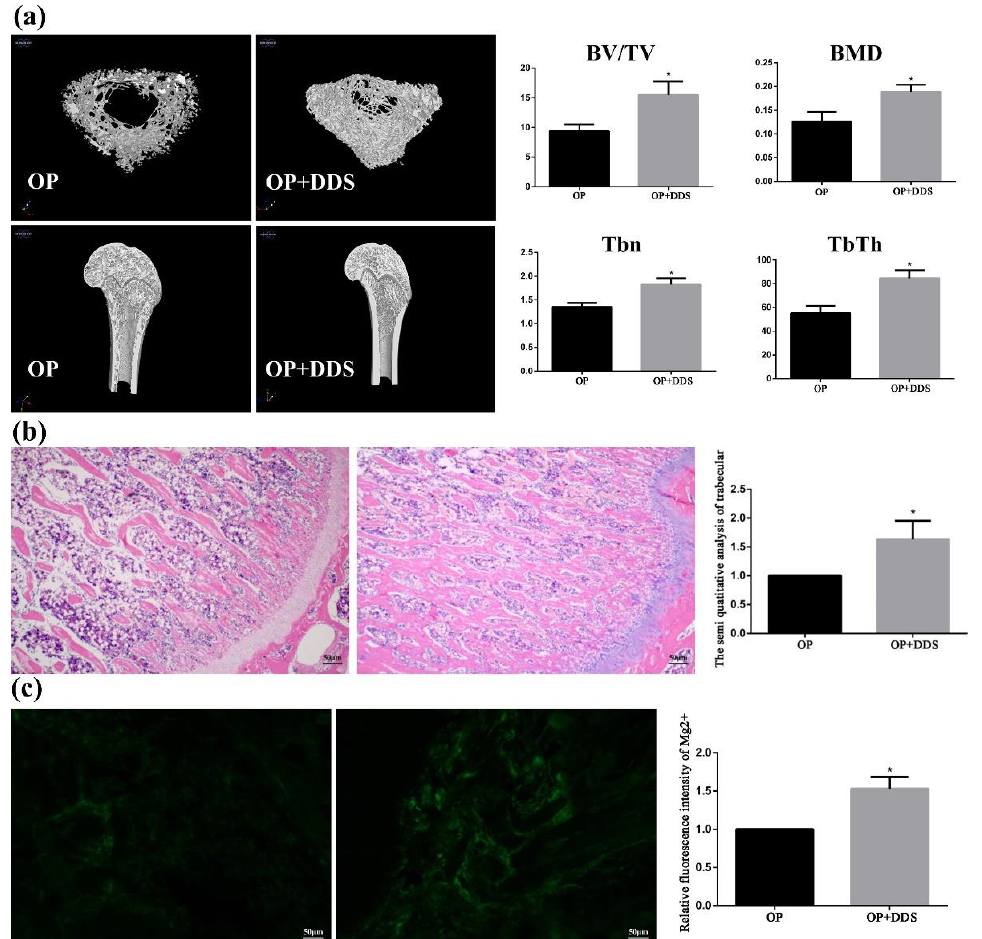
Figure 11. The 3D images of proximal tibia reconstructed by the Micro-CT ( a ), HE staining results of Trabeculae ( b ), and Magnesium content in bone tissue ( c ) of the treatment group rats and osteoporosis group rats. ”*” represents the treatment group compared with the OP group.